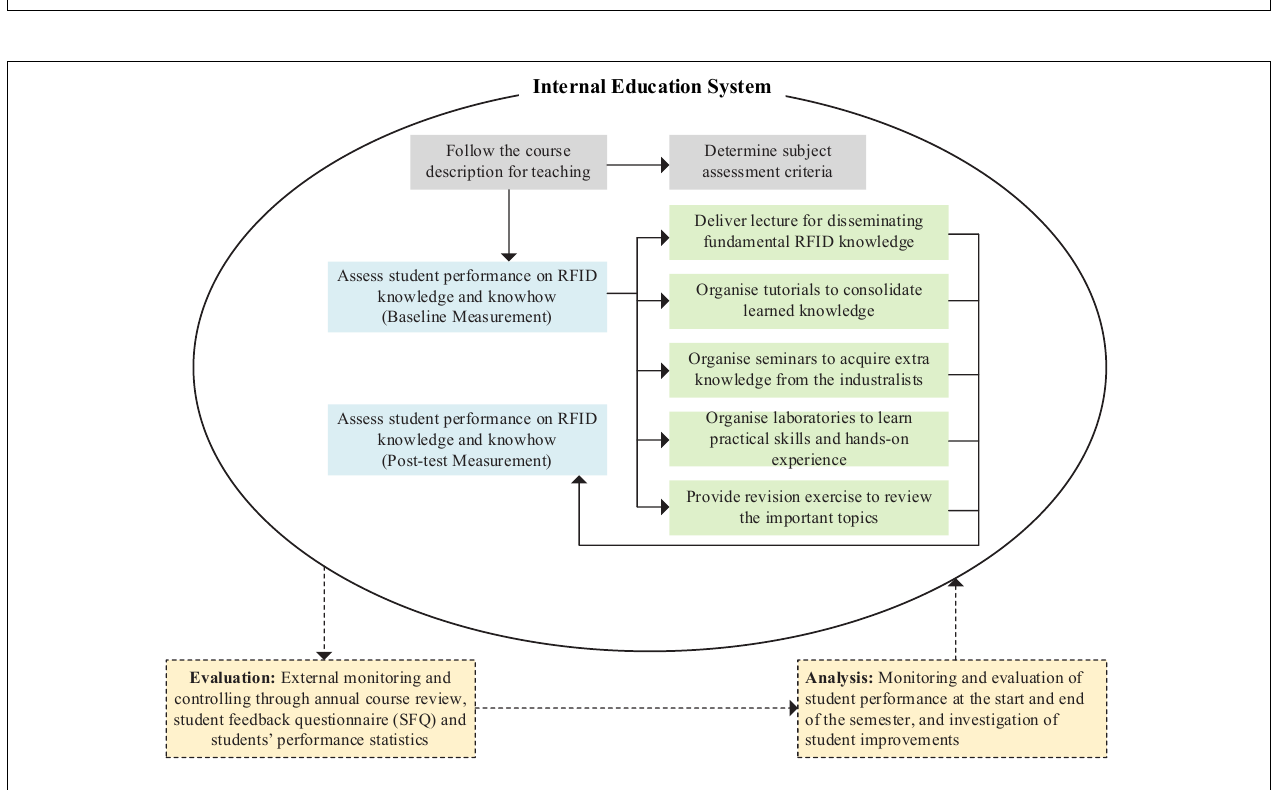
FIGURE 6 | Graphical illustration of the RFID education